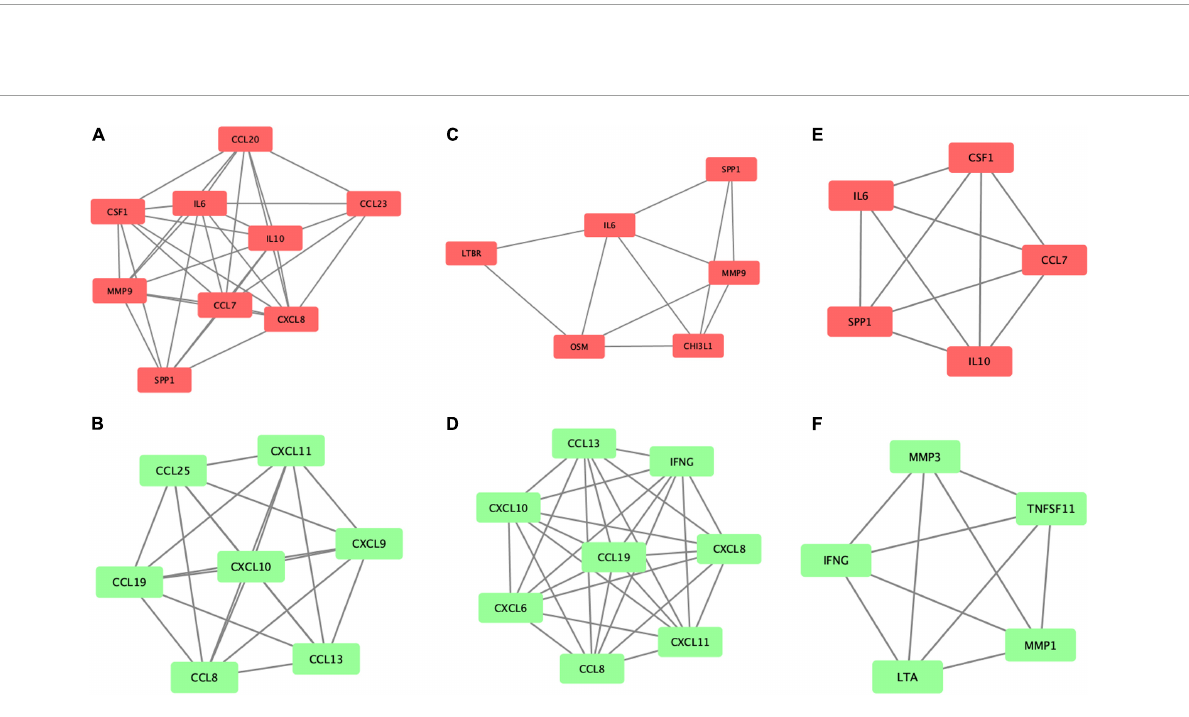
FIGURE4 Potential functional modules with the best score in the PPI network. The most significant module for the increased proteins (A) and decreased proteins (B) in the cryoballoon group; (C,D) in the radiofrequency balloon group and (E,F) in the radiofrequency group, respectively. The significant modules were analyzed by using MCODE plugin, and then module networks were visualized using Cytoscape